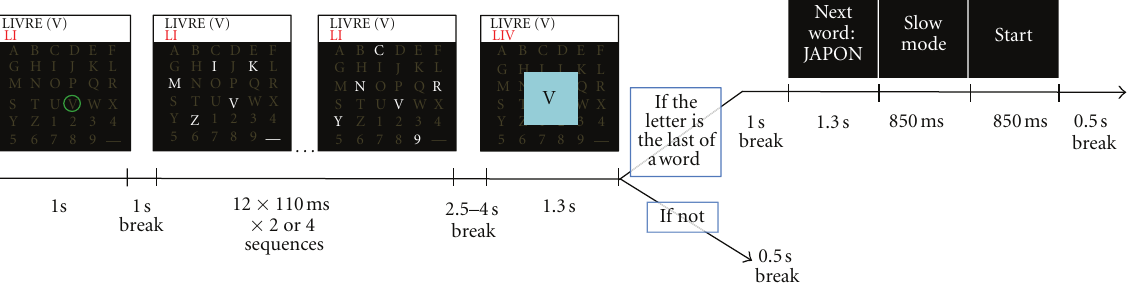
Figure 2: The course of one trial. The target letter is indicated by a green circle, for 1 second. Letters are flashed by group of 6 letters. After a delay, the letter chosen by the P300 classifier is displayed for 1.3 seconds. If the letter is the last of the word, a 4.5 second break occurs during which a display indicates the next word and the di ffi culty level (slow or fast spelling mode). If not, there is a short 0.5 s break before the next green circle